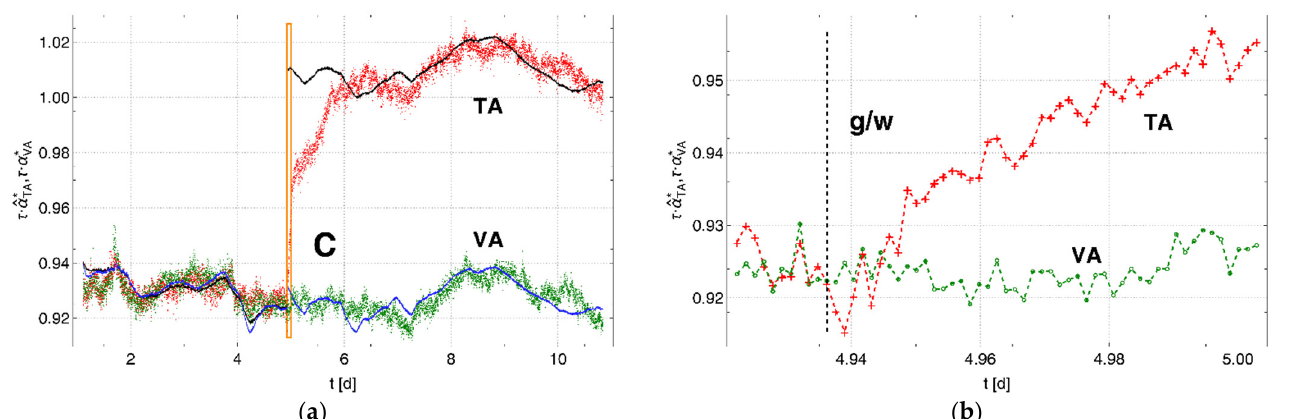
Figure 6. ( a ) Pressure changes ˆ α ∗ (red) and α ∗ (green) adjusted to each other and multiplied by the time parameter τ for Set 1 for both phases of the experiment. The solid lines (TA: black, VA: blue) represent the calculated data. The data region within the orange box marked C indicates the transition between Phases 1 and 2, where the vapor-saturated air in the surroundings of the membrane tube in the test container was replaced by liquid water. The region of data within the orange box is shown in more detail in ( b ). The black line marked g/w indicates the time at which liquid water starts to cover the membrane surface of the membrane tube.